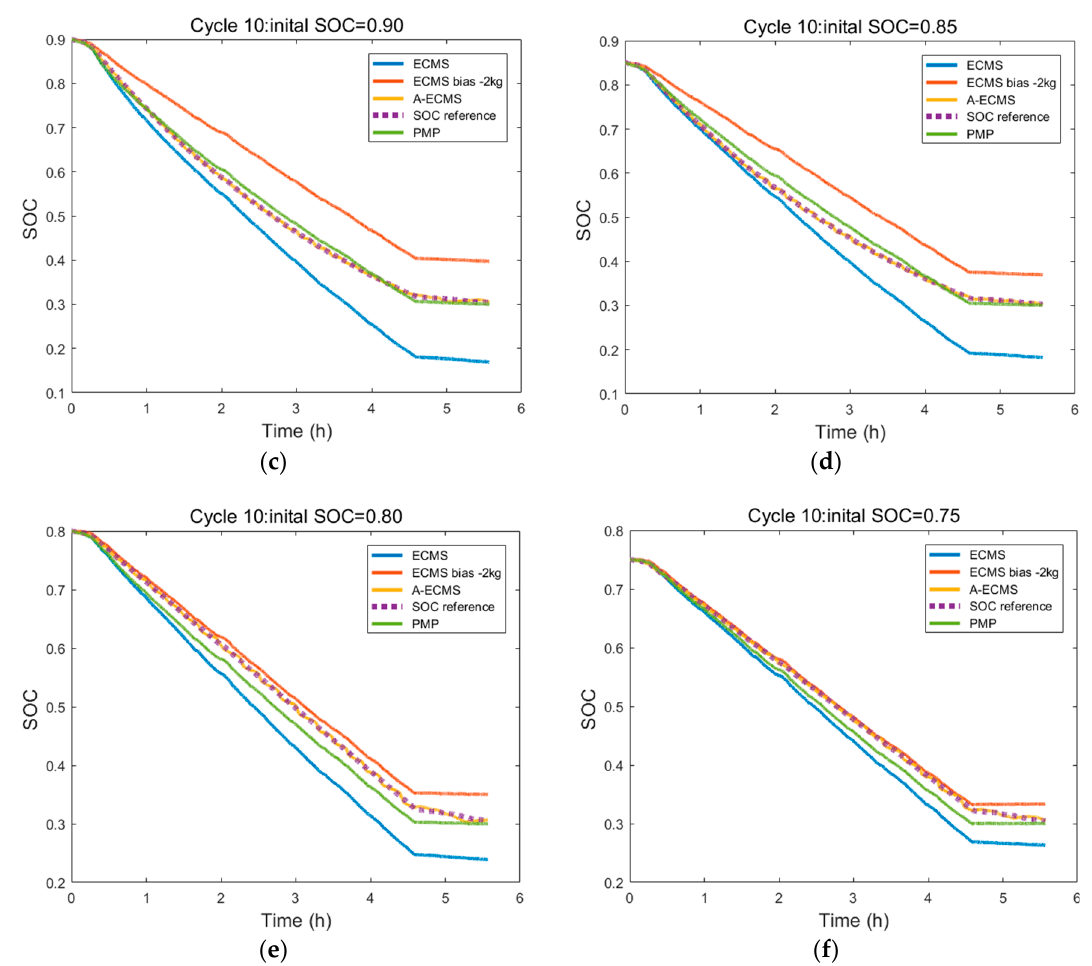
Figure 14. The strategies comparison under different initial SOC (Cycle 10): ( a ) SOC = 1.00; ( b ) SOC = 0.95; ( c ) SOC = 0.90; ( d ) SOC = 0.85; ( e ) SOC = 0.80; ( f ) SOC = 0.75.